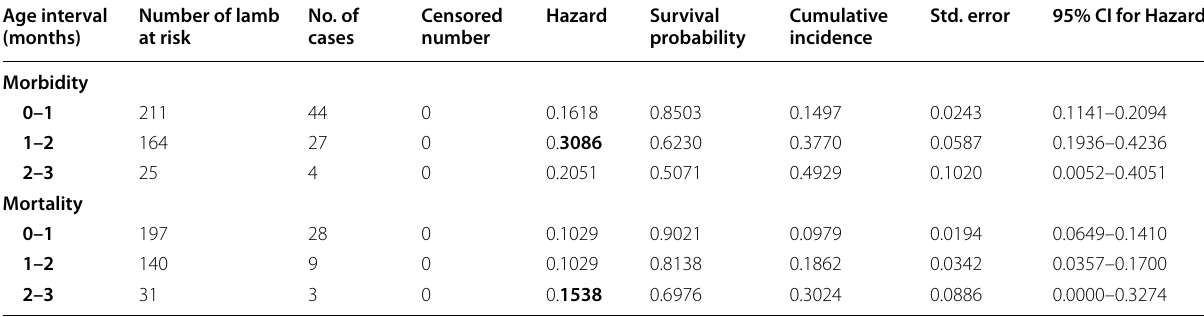
Table 3 Kaplan-Meier estimate of the hazard of morbidity and mortality in lamb from birth to three months Age interval Number of lamb (months) at risk